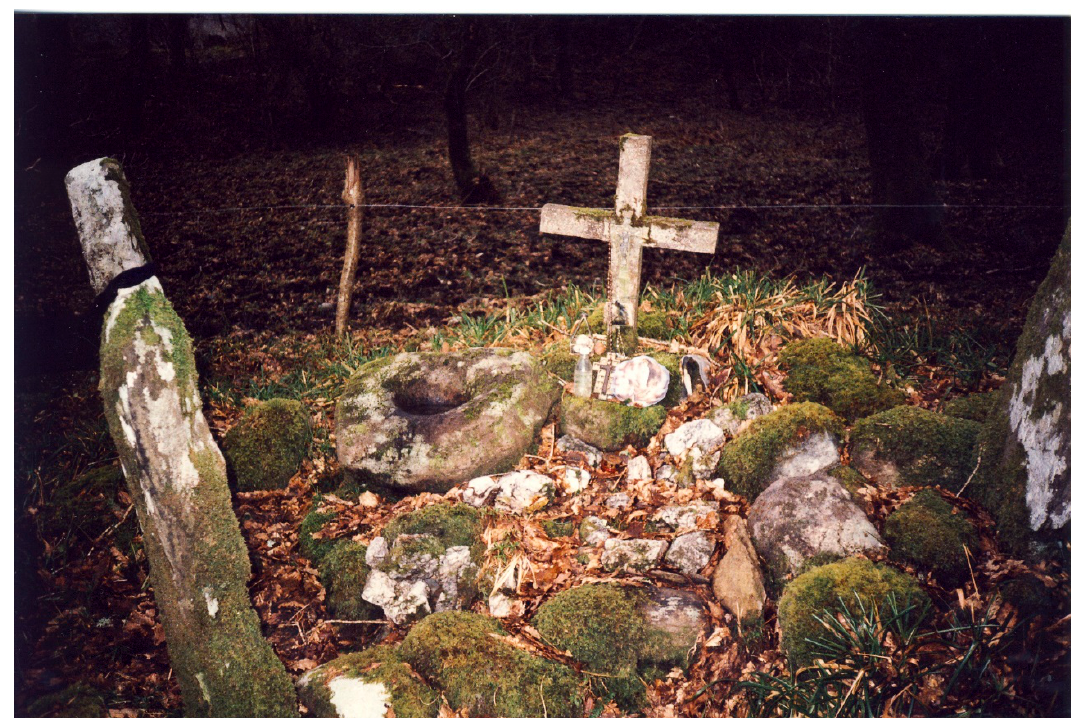
Figure 2. St. Abbán’s grave near Ballyvourney, Co. Cork. Figure 2. St. Abb á n’s grave near Ballyvourney, Co.